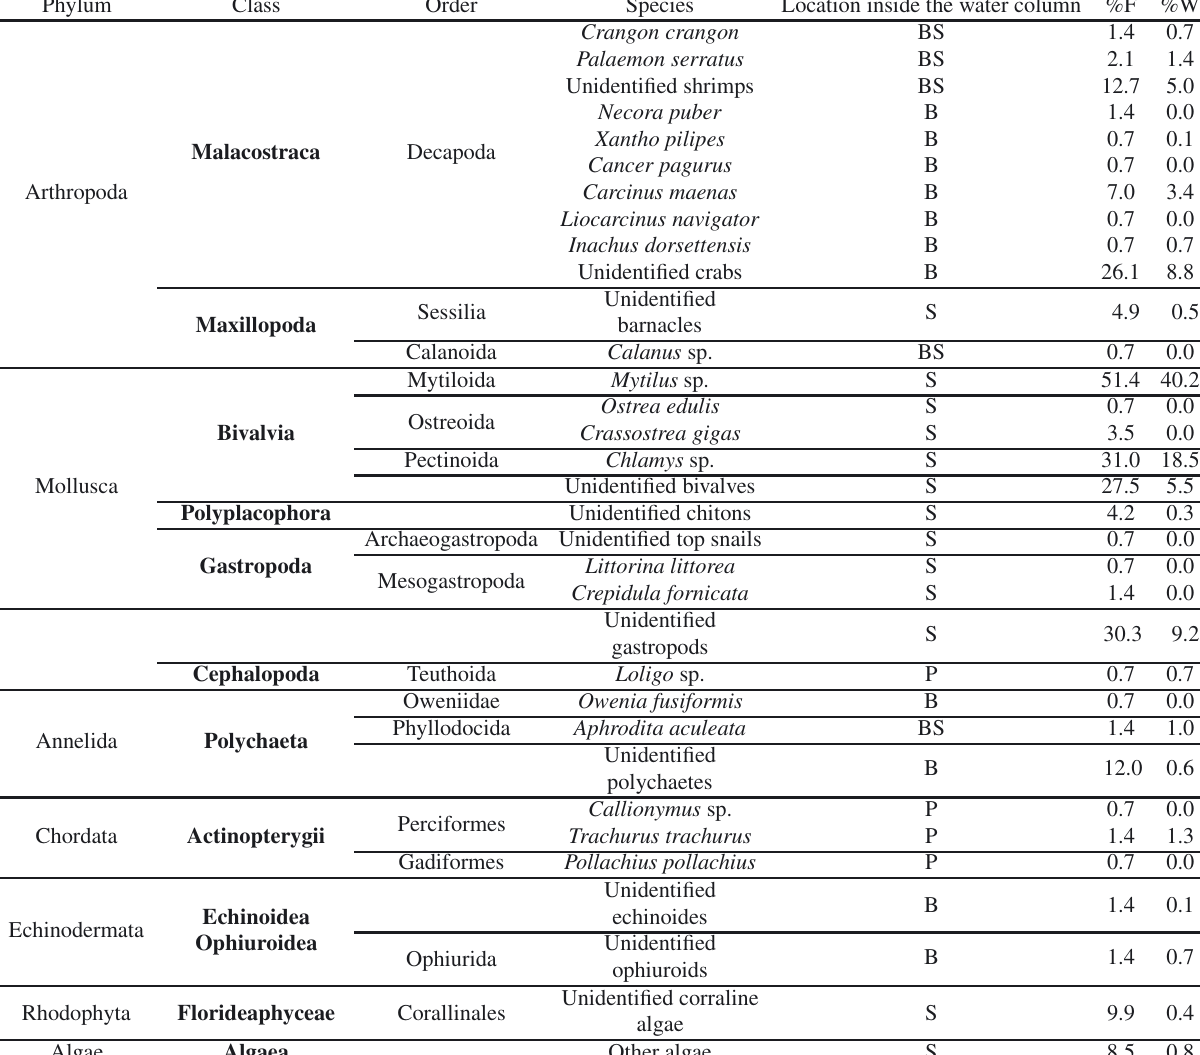
Table 5. Prey-specific indices of percentage of frequency of occurrence (%F) and percentage of weight proportion (%W) for each prey item identified by morphological and genetic analysis in the diet of Sparus aurata . Species were grouped into 12 classes for analysis (in bold characters). Several prey items were not identified to the species level and were included inside unidentified groups. Life history